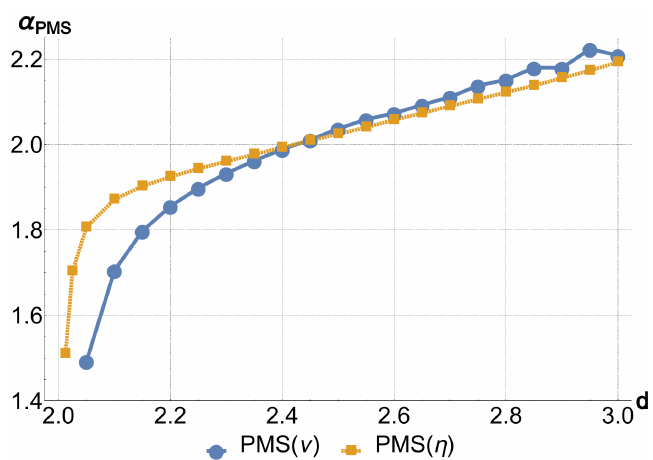
Figure 2: (Color online) Evolution of the PMS values of the regulator parameter α depending on dimensionality d for N = 2. A substantial increase of its variation occurs for d approaching 2. No PMS value is found for d in the immediate vicinity of